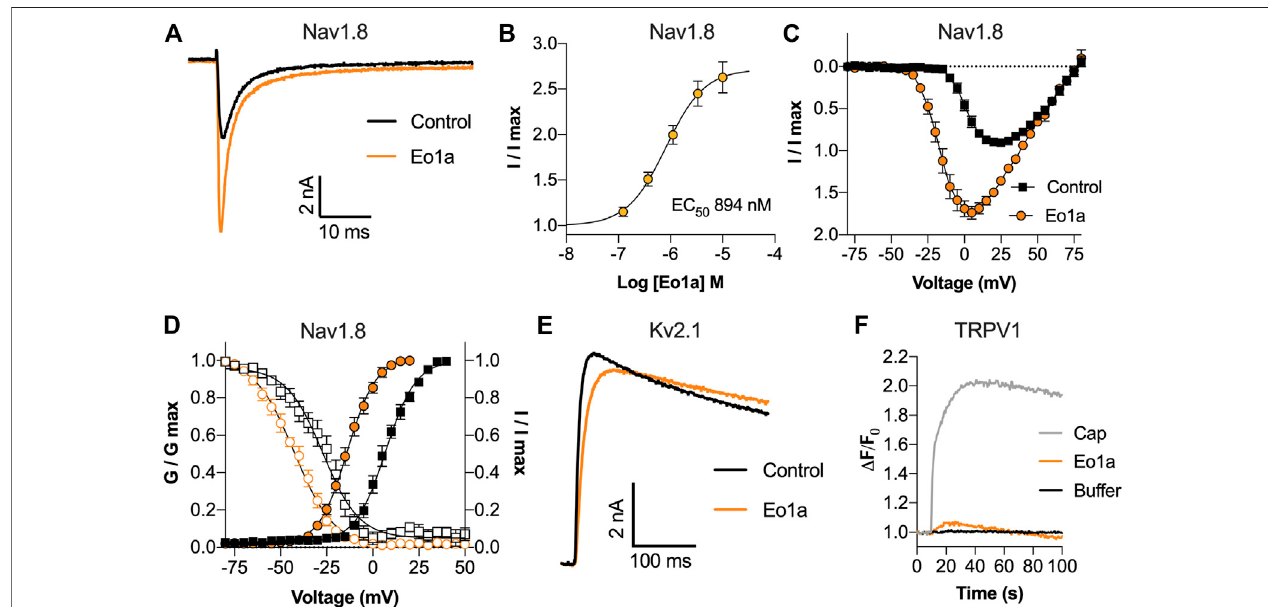
FIGURE2| ActivityofEo1aatNa V 1.8,K V 2.1andTRPV1. (A) RepresentativeNa V 1.8currenttracebeforeandafteradditionof1 μ MEo1a.Currentswereelicitedby a 50 ms pulse to +10 mV from a holding potential of − 90 mV. (B) Eo1a increased Na V 1.8 peak current with an EC 50 of 894 ± 146 nM ( n (cid:1) 7 cells). (C) I - V relationship before and after addition of 10 μ M Eo1a ( n (cid:1) 4 cells). (D) Conductance-voltage ( fi lled symbols) and steady-state fast inactivation (open symbols) before (black) and after (orange) addition of 10 μ M Eo1a ( n (cid:1) 4 cells). Eo1a shifted the voltage dependence of activation V 1/2 by − 20.5 mV and inactivation V 1/2 by − 15.5 mV. Data are presented as mean ± SEM. (E) Representative K V 2.1 current trace before and after addition of 10 μ M Eo1a. Currents were elicited by a 300 ms pulse to +50 mV from a holding potential of − 80 mV. (F) Changes in Ca 2+ dye fl uorescence over baseline in TRPV1-expressing cells after addition of capsaicin (300 nM), Eo1a (10 μ M) or buffer (mean of n (cid:1) 3